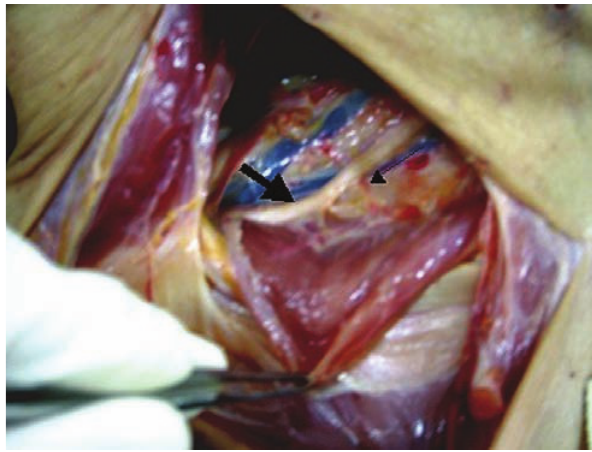
Figure 2 - Musculocutaneous nerve (wide arrow) and its proximal motor branch (narrow arrow), as well as their points of entry into the medially separated coracobrachial muscle